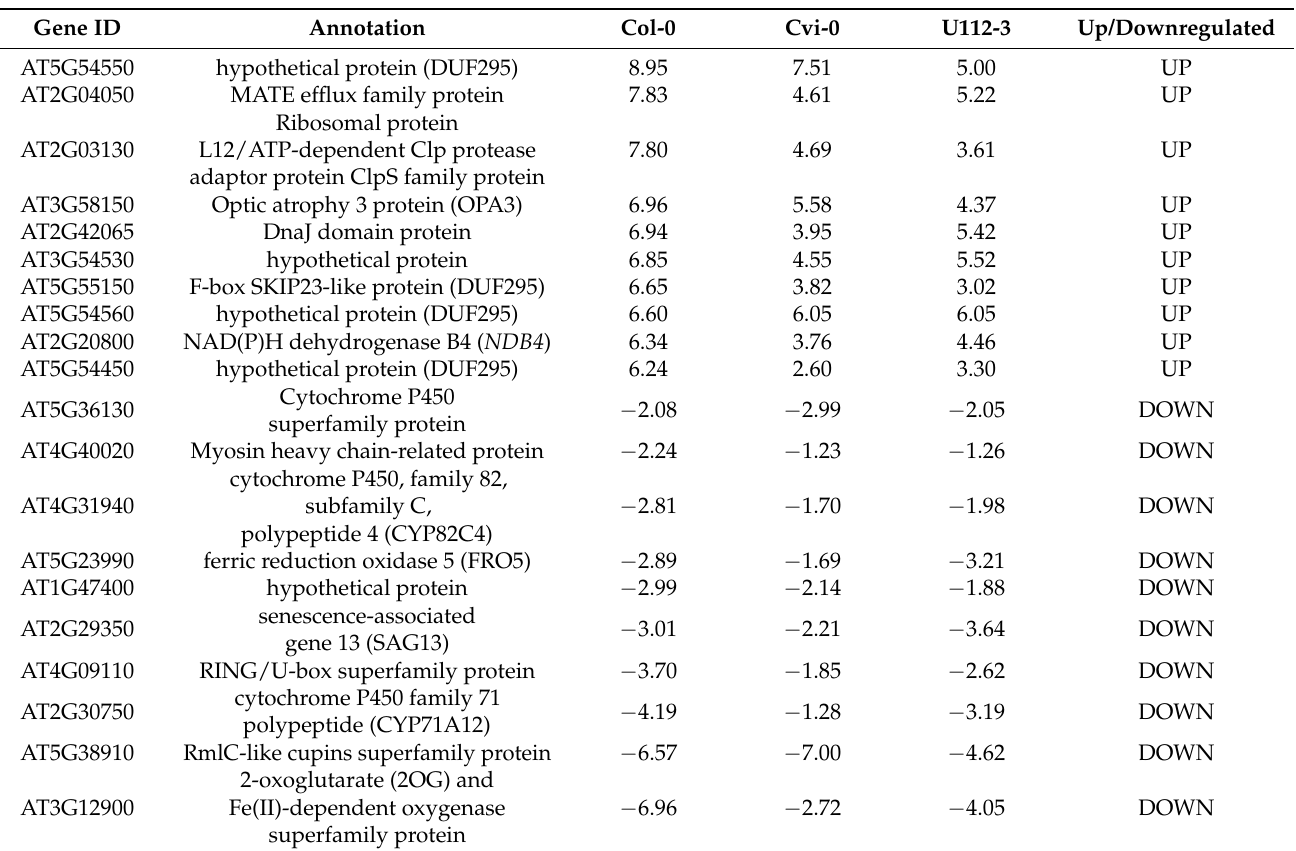
Figure 7. Venn diagram showing the number of differentially expressed genes obtained from ailan- thone treatment with three Arabidopsis ecotypes, Col0, Cvi-0, and U112-3. Table 2. Common DEGs identified across 3 ecotypes in response to Ailanthone.